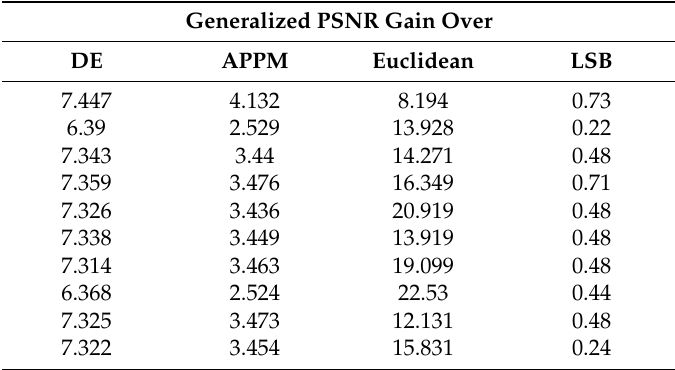
Table 3. Gain of GenPSNR over the